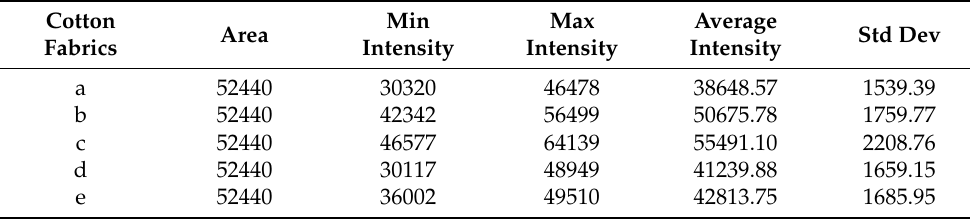
Figure 5. Fluorescence images of ( a ) treated cotton fabric, ( b ) EDA-CDs/CF, ( c ) MIPs/MT@EDA- CDs/CF, ( d ) MIPs@EDA-CDs/CF, and ( e ) NIPs@EDA-CDs/CF under UV radiation. Table 1. RGB intensity of cotton fabrics: (a) treated cotton fabric, (b) EDA-CDs/CF, (c)